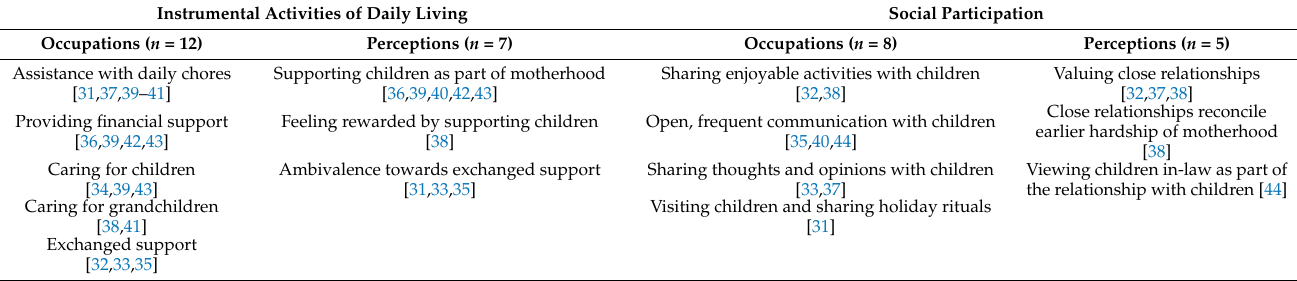
Table 2. Occupations and perceptions within the maternal role identified in the 14